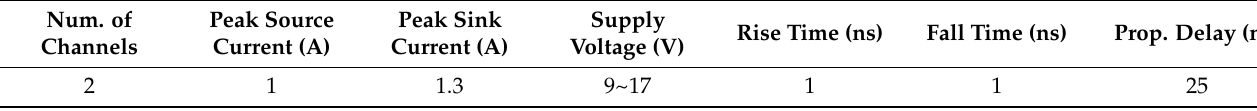
Table 21. Commercial GaN HEMT driver by On Semiconductor.